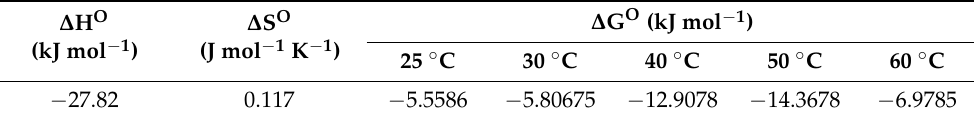
Table 6. Thermodynamic parameters for the adsorption of IV2R ions onto P. capillacea